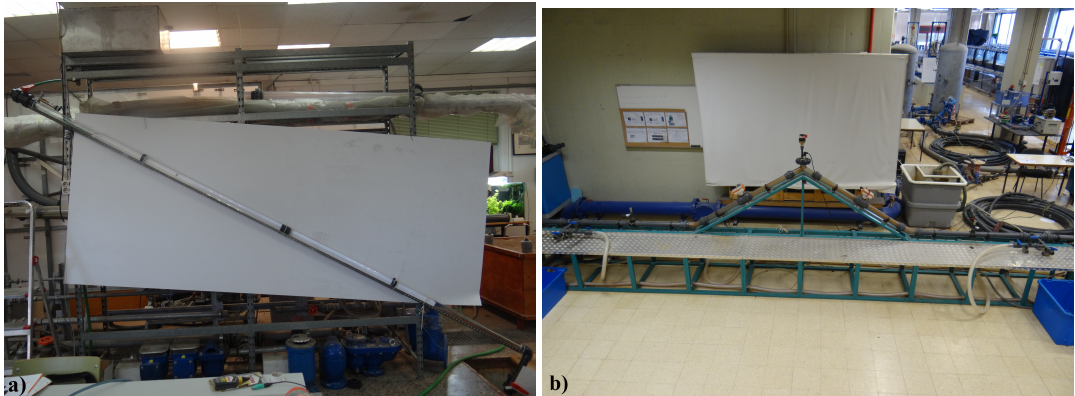
Figure 1. Experimental facilities to validate the emptying process: ( a ) single pipe (Universitat Politècnica de València, Spain). ( b ) pipeline of irregular profile (University of Lisbon,